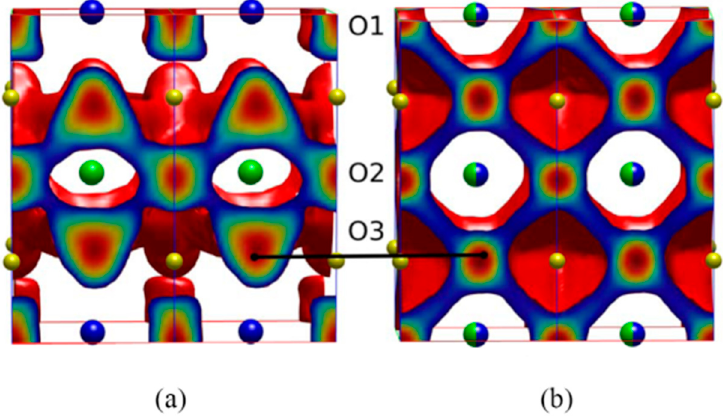
Figure 3. A schematic representation of the MD calculated oxygen density profiles for GdBaCo 2 O 5.5 . ( a ) when ordered (anisotropic diffusion) and ( b ) fully disordered (isotropic diffusion) [137]. Blue and green spheres represent Ba and Gd ions respectively (Copyright 2011 Royal Society of Chemistry).